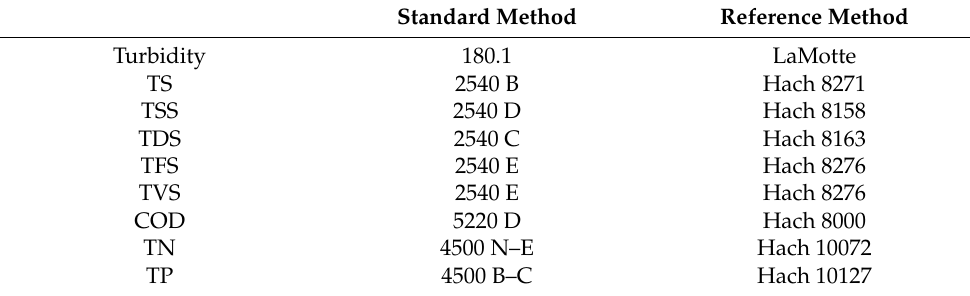
Table 1. Standard Method for Examination of Water and Wastewater.